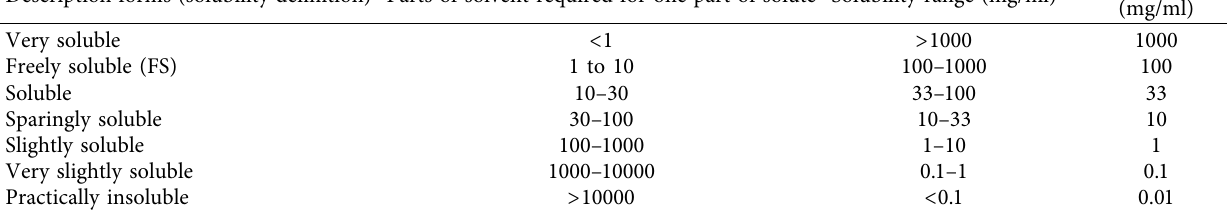
Table 1: The definitions of various solubility terms [9].